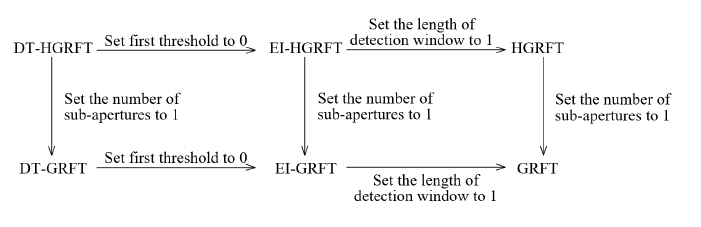
Figure 10. Simplification of DT-HGRFT in special